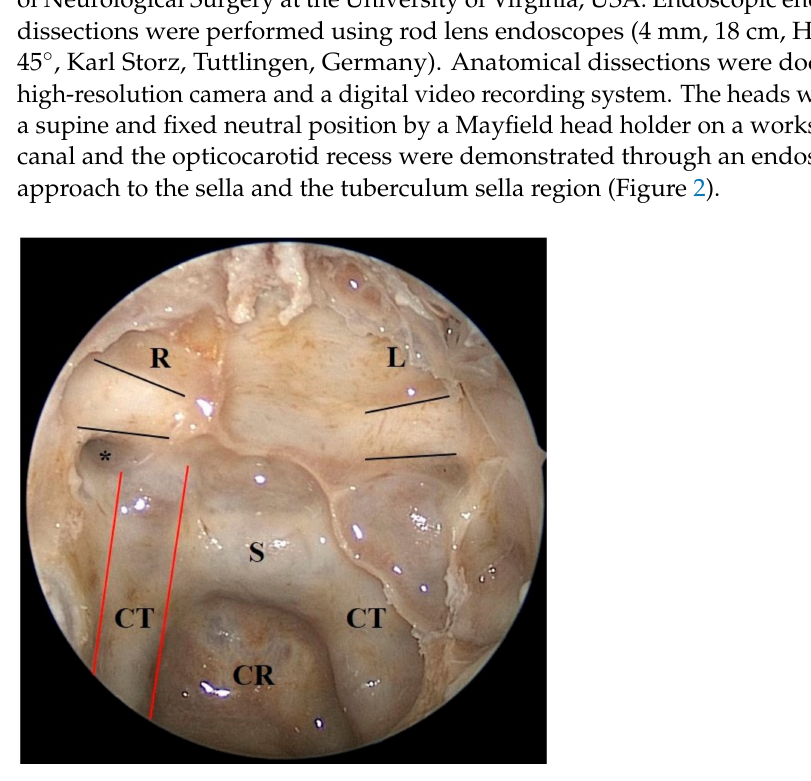
Figure 2. Cadaveric demonstration of anatomical landmarks in the sphenoid sinus. The two black lines outline the canalicular segment of the optic nerve. The two red lines show the course of the internal carotid artery in the sphenoid sinus. * points to the opticocarotid recess. CR: Clival Recess; CT: Carotid Tubercule; S: